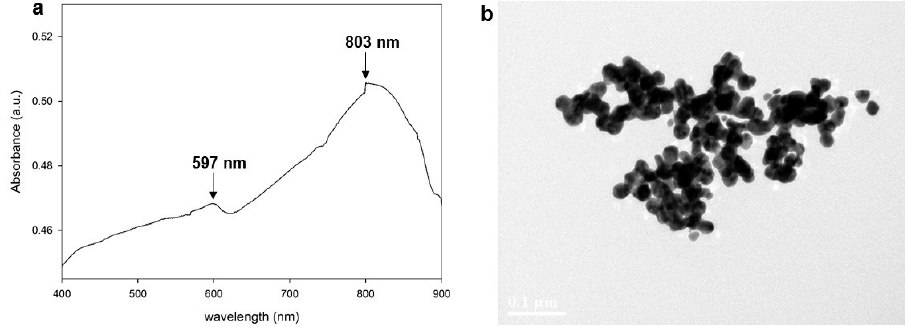
Figure 2. ( a ) UV–Vis–NIR spectrum and corresponding ( b ) transmission electron micrographs of Au nanoparticle aggregates in EDMS after >8 h of